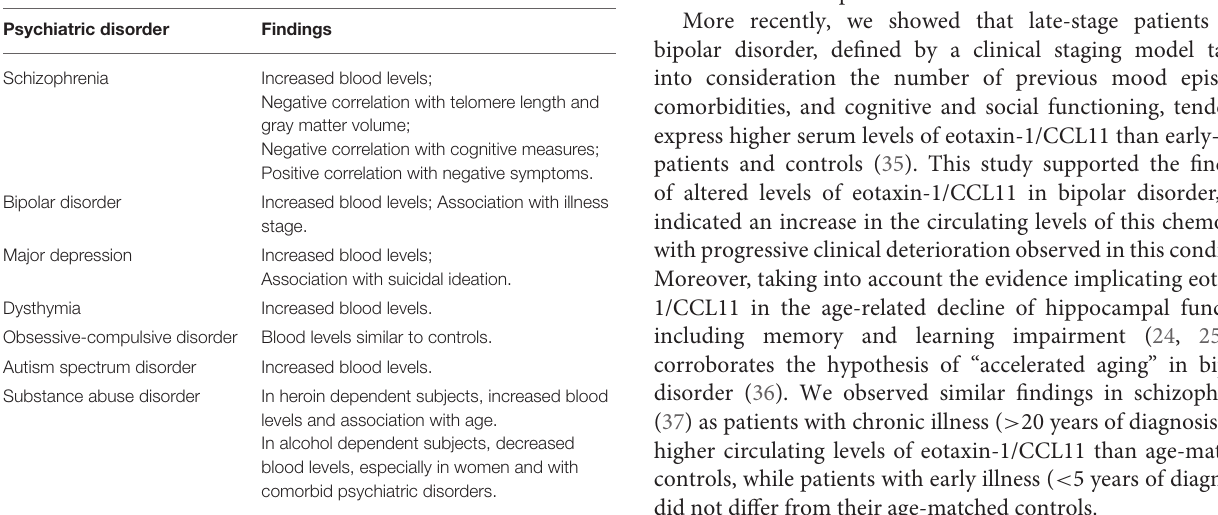
TABLE 1 | Main findings regarding eotaxin-1/CCL11 levels in major psychiatric